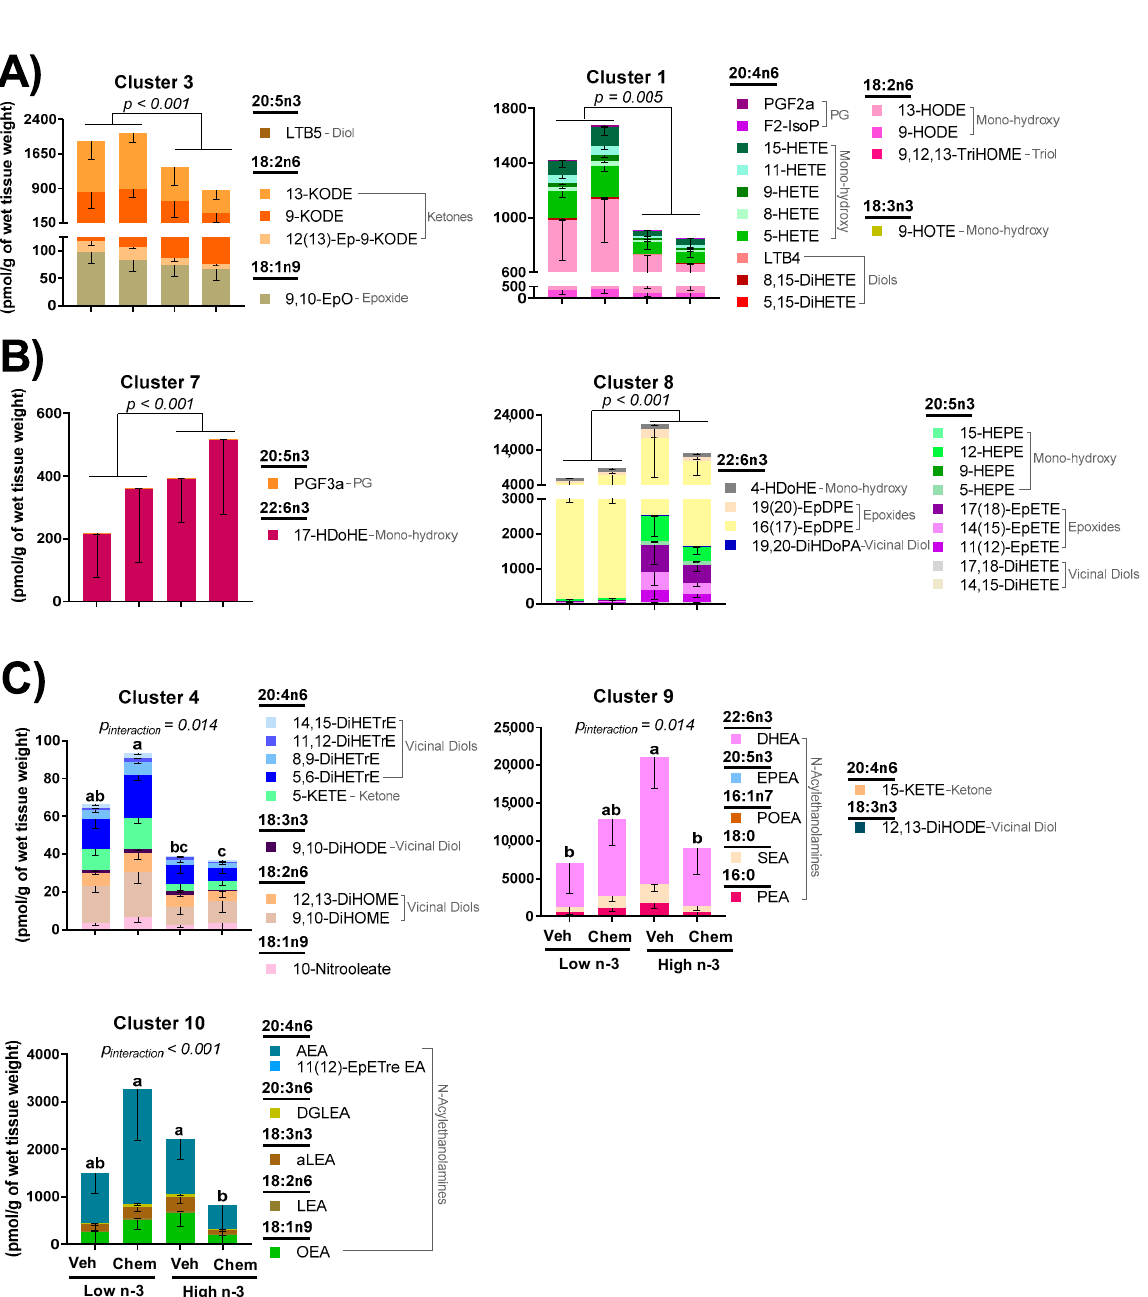
Figure 3. Heart mitochondrial lipid mediator changes between groups using hierarchical cluster analysis. Clusters shown were either ( A ) significantly higher in Low n-3-fed mice; ( B ) significantly higher in High n-3 fed mice; ( C ) or had a significant diet by chemo interaction. Data presented as group means ± SEM ( n = 4/group). Differences in cluster means were determined using variables as the fixed effect and subject as a random effect. One-way MANOVA was used for the variables with no interaction. Two-way MANOVA with Tukey post testing was used for the variables with significant interaction between diet and chemo (different lowercase letters denote differences in group